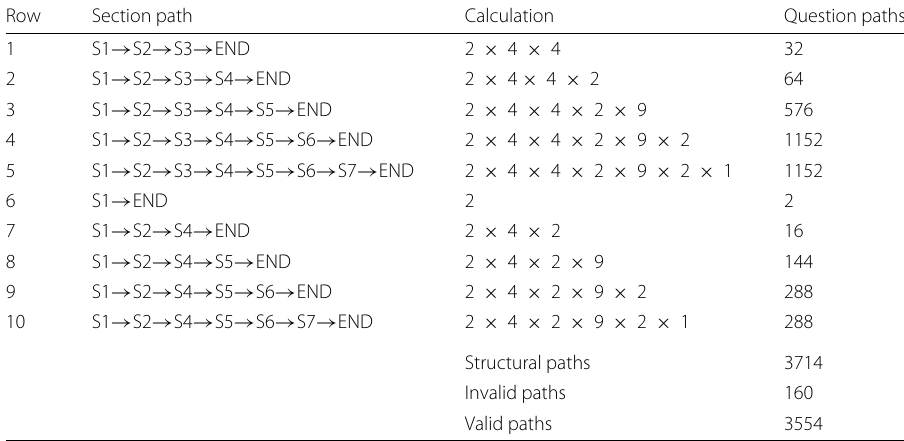
Table 3 Composite calculation of number of question paths Row Section